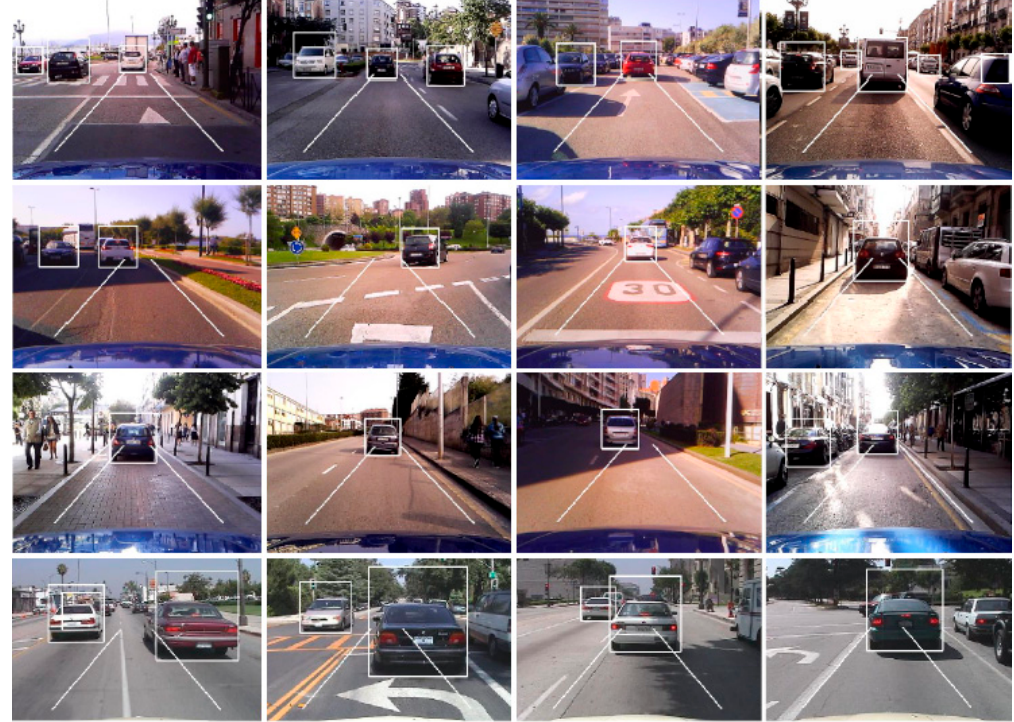
Figure 6. Example results of the hypotheses generation.